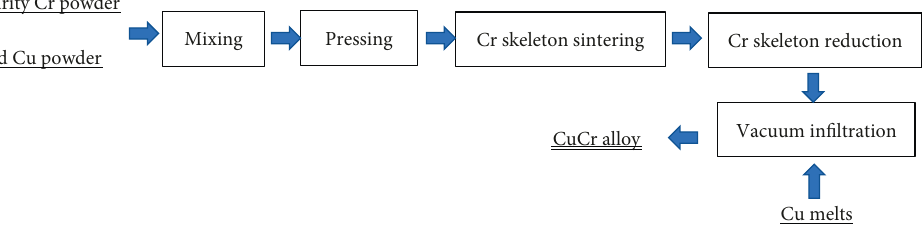
Figure 2: Process route of CuCr alloy preparation by infiltration method